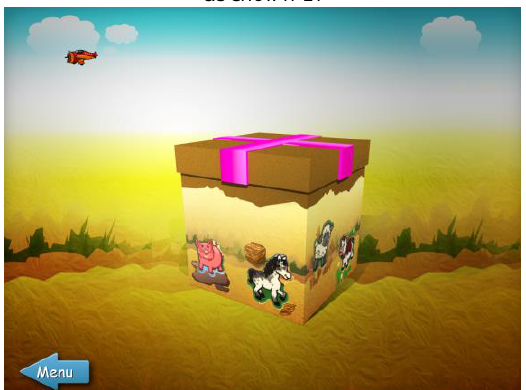
First Level (from age 3 to